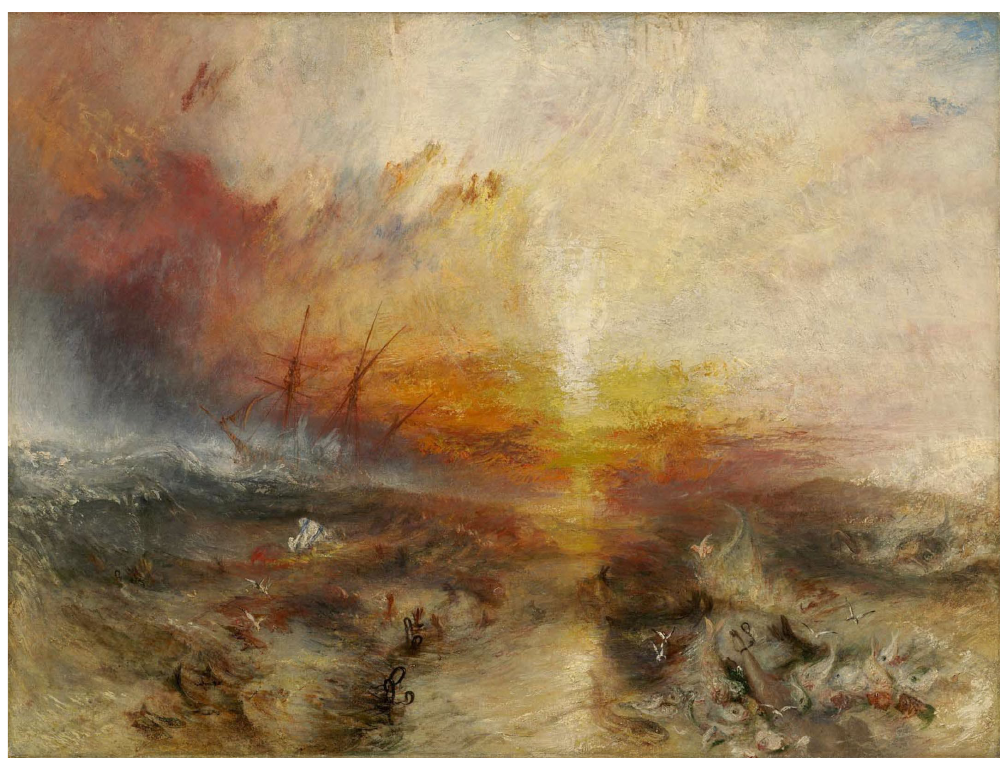
Fig. 1 J.M.W. Turner, The